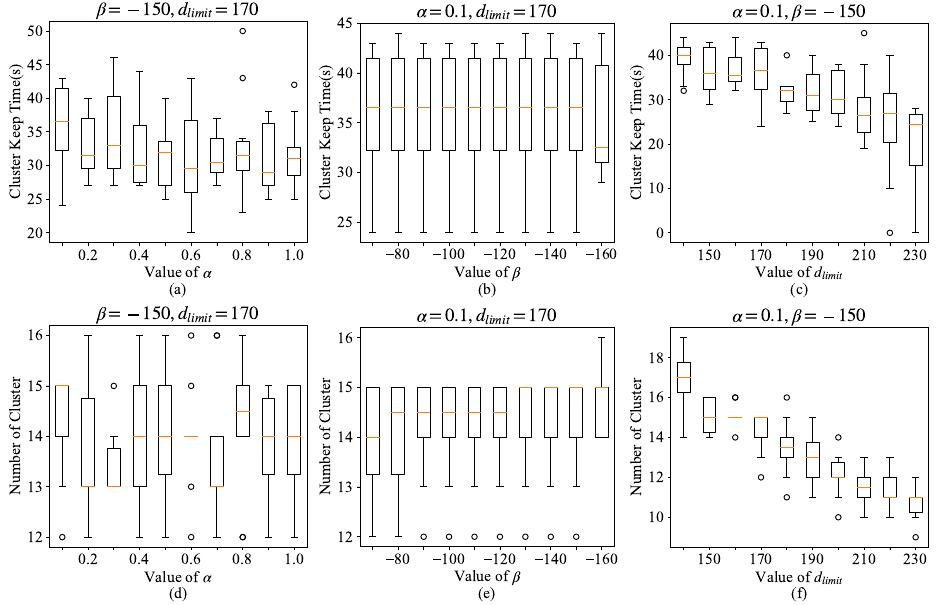
Figure 5. ( a – c ) are the effects of changing the α , β , d limit , respectively, on the stability of clusters; ( d – f ) are the effects of changing the α , β , d limit , respectively, on the number of clusters